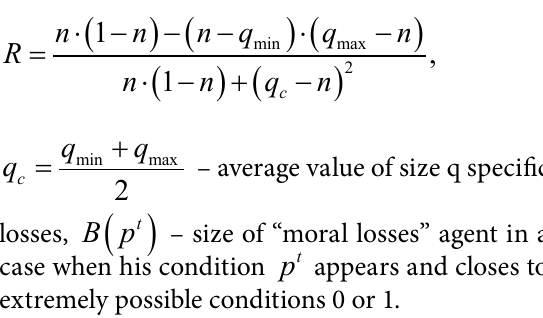
Introduction of